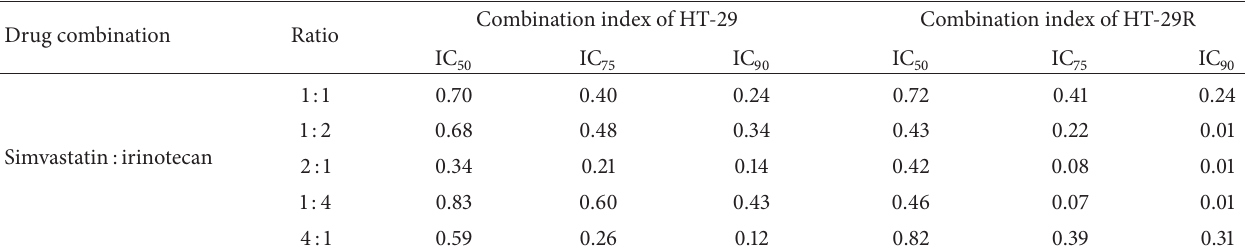
Table 2: Combination index values of simvastatin and irinotecan in HT-29 and HT-29R cells. Drug combination